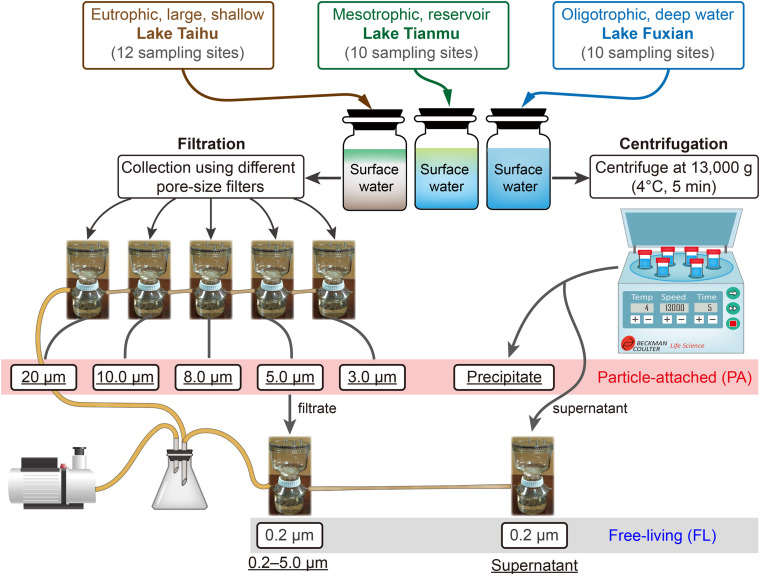
The schematic diagram of experiment design, and the different treatments for collecting particle-attached (PA, six treatments in the red box) from Lake Taihu, Lake Tianmu, and Lake Fuxian. The <5.0 μm-filtrate and the supernatant after centrifugation are subsequently filtrated by 0.2 μm filter membranes and are considered as free-living (FL, in the gray box) bacterial samples. The terms underlined represent the designated names of the treatments.